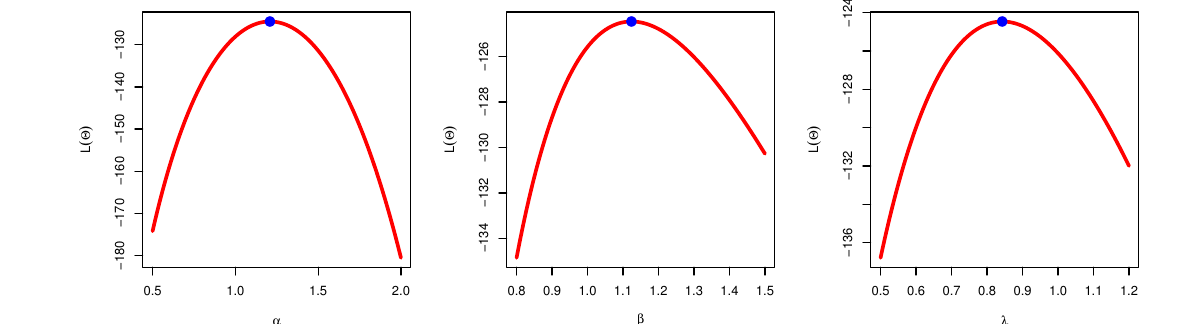
Figure 9. Profile likelihood of UEPD for the milk production data.